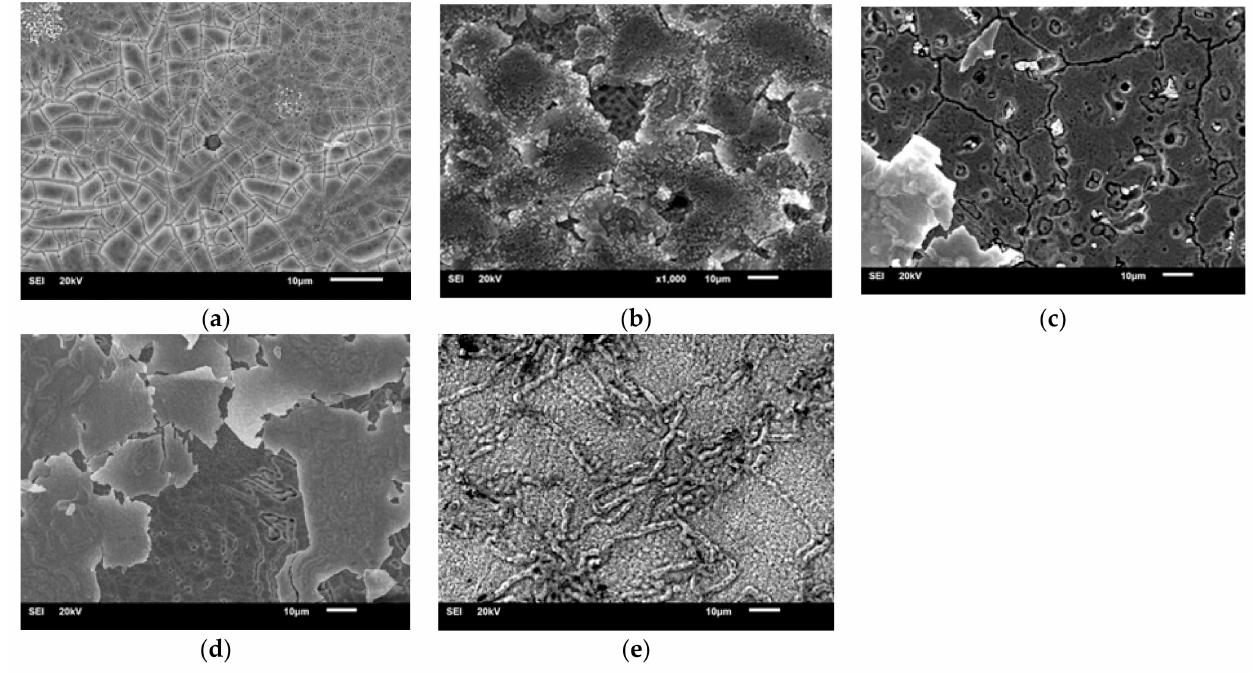
Figure 9. SEM SE images of samples’ surfaces after CT: ( a ) CST1; ( b ) CST2; ( c ) MSM; ( d ) SLM1; ( e )